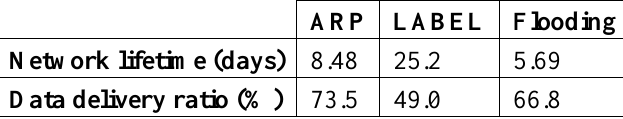
Table 5. Network life with default